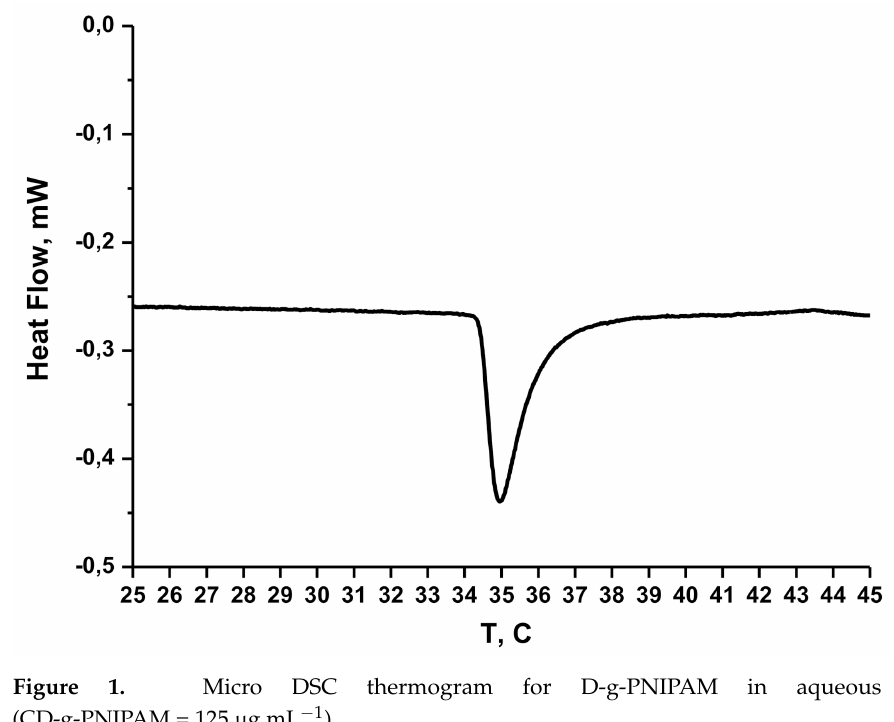
Figure 1. Micro DSC thermogram for D-g-PNIPAM in aqueous solution (CD-g-PNIPAM = 125 µ g mL − 1